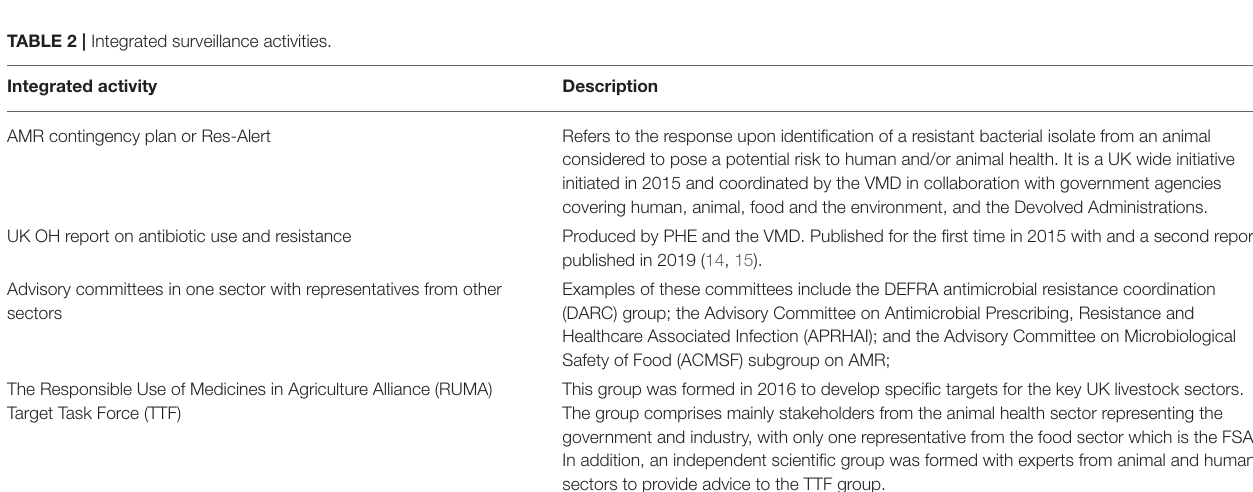
FIGURE 2 | Overview of themes (circles) and subthemes (rectangles) developed during the analysis of the interviews with 18 stakeholders.